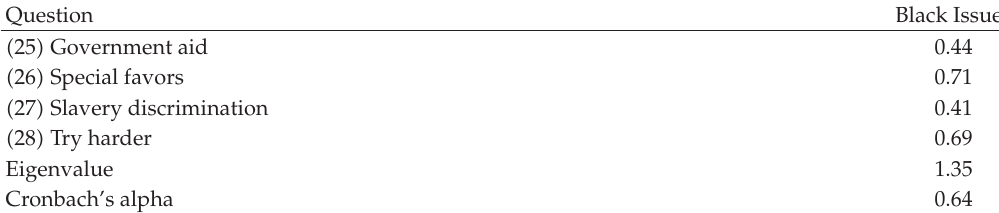
Table 3: Factor loadings for Black issues.